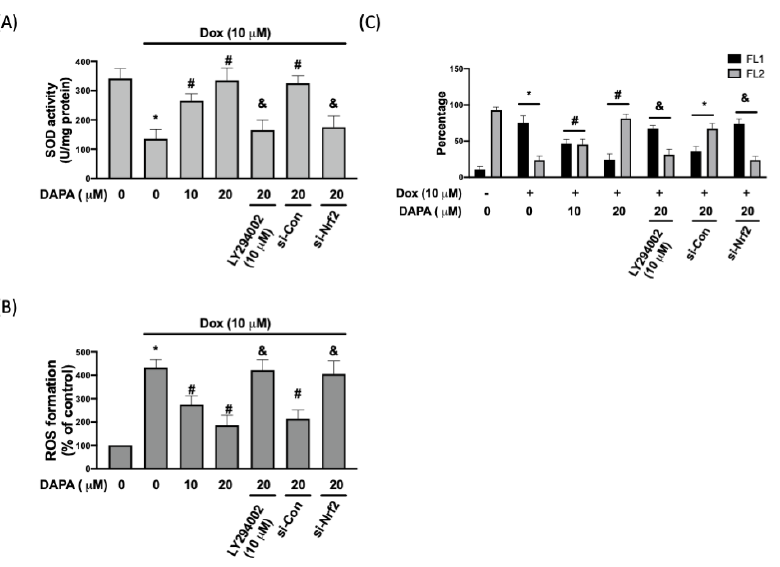
Figure 3. DAPA diminishes Dox-induced oxidative stress and mitochondrial damage. ( A ) SOD activity, ( B ) ROS formation, and ( C ) percentage of cells expressing JC-1 monomers (green fluorescence; FL1) and JC-1 aggregates (red fluorescence; FL2) in Dox-treated cells with or without DAPA treatment were assessed. Results are shown as means ± SD of three independent experiments. Sta- tistical analysis was performed using one-way ANOVA with a Bonferroni post hoc test. [* p < 0.05